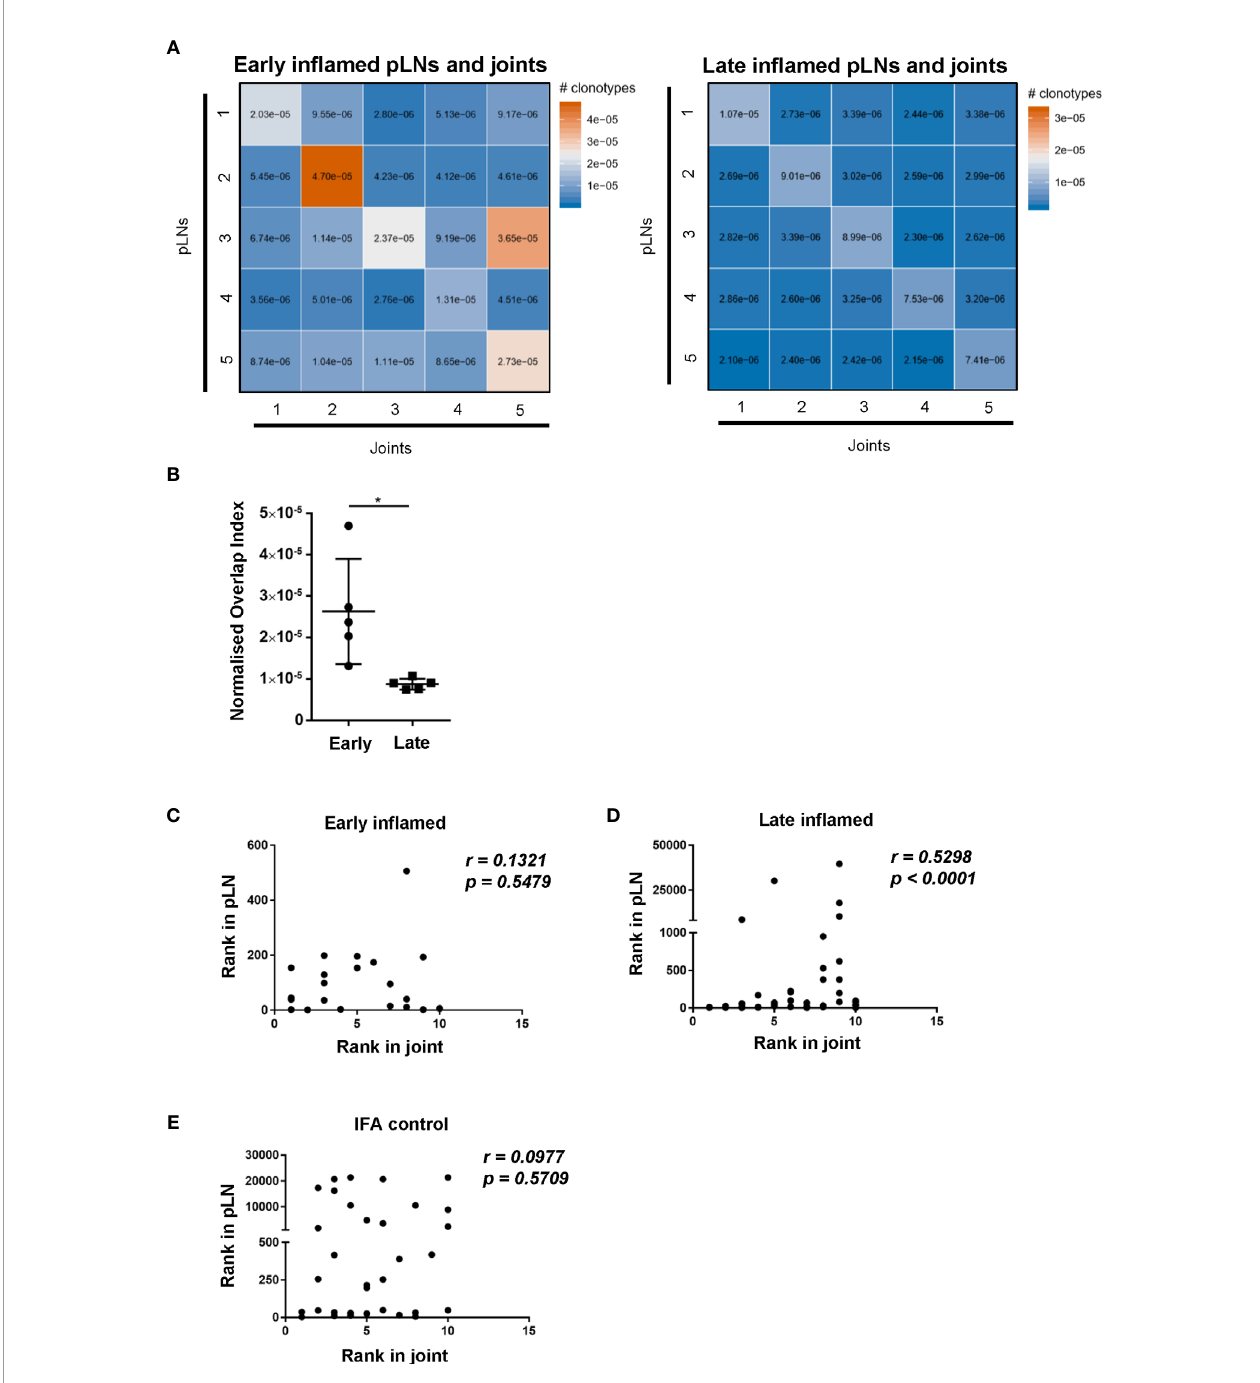
FIGURE 6 | Degree of CDR3 b amino acid sequence overlap and correlation of most abundant clones between in fl amed pLNs and joints at the early and late phases. (A) Heatmaps of normalised number of CDR3 b amino acid sequences (see methods) between in fl amed pLNs and joints at the early (left) and late (right) phases. (B) Graph representing the intersects (diagonal) of (A) representing CDR3 b sequence overlap between in fl amed pLNs and joint within the same animal. (C – E) Correlation of the top 10 ranked clones in joints with their rank in respective pLN samples. The rank of each of the top 10 clones in (C) in fl amed joint at the early phase, (D) in fl amed joint at the late phase, and (E) IFA control joint samples were plotted against the rank of that clone in respective pLN samples. Data is representative of one experiment with n=5 for the early and late phase in fl amed groups and n=3 for controls. Graph in (B) is representative of mean ± SD with each point representing individual experimental mice. * represents p<0.05. In C-E correlations (r) were calculated using Spearman ’ s correlation after testing for normality of the data using the D ’ Agostino-Pearson test. p represents the p